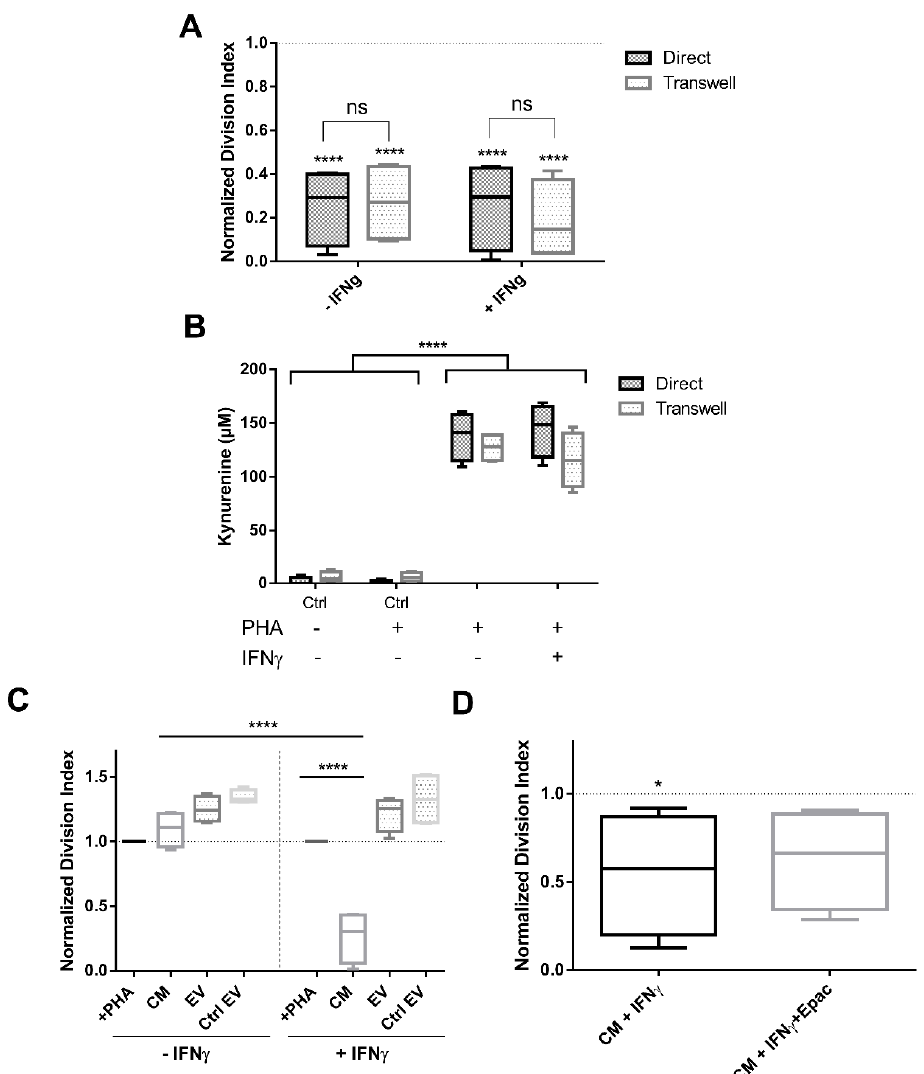
Figure 3. PBMC were equally inhibited in direct and transwell cocultures, although EV failed to suppress their proliferation regardless of IFN γ pre-stimulation. ( A ) PBMC division index evaluation in direct and transwell culture conditions, n = 4. ( B ) Kynurenine concentrations measured in direct and transwell coculture supernatants, n = 4. ( C ) Cocultures with CM and EV isolated from stimulated and not stimulated ASC, n = 4. ( D ) Cultures with CM + IFN γ together with the addition of IDO inhibitor Epacadostat, n = 4. Box: interquartile range; whiskers: minimum to maximum; line: median. Dotted lines represent the normalisation referred to the positive control. Asterisks depicted at the top of the lines represent the significance of the individual value with respect to their own control. Lines with asterisks depict the significance between two conditions (n.s. p ≥ 0.05, * p < 0.05, **** p < 0.0001).